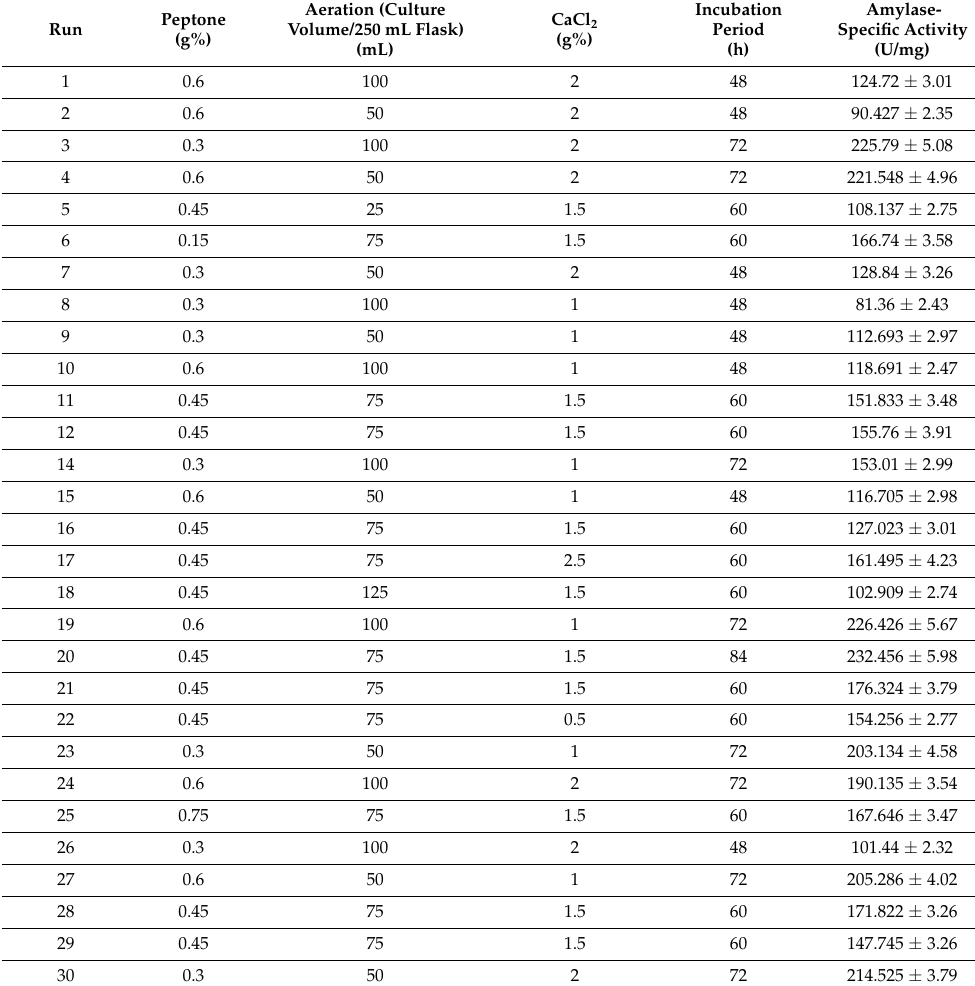
Table 5. Results of CCD design to optimize the variables involved in alpha-amylase production by